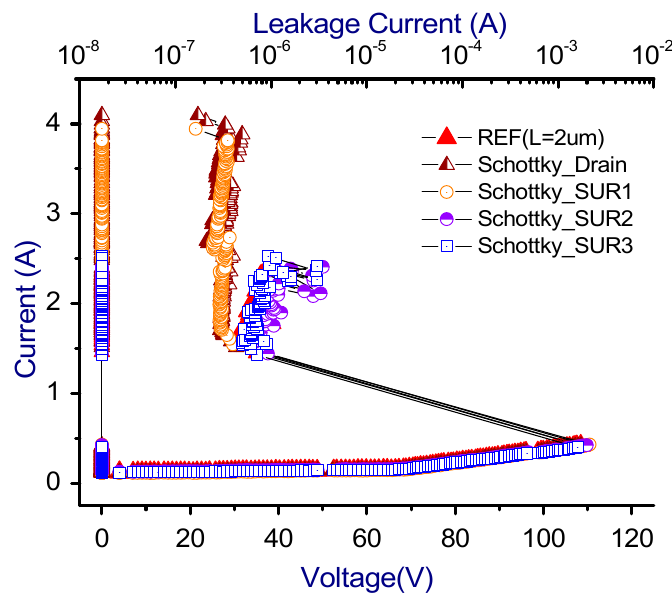
Figure 18. Snapback I-V curves and leakage currents of HV nLDMOSs with embedded Schottky-diode modulation. Table 5. Snapback extracted parameters of HV nLDMOSs with embedded Schottky-diode modulation.